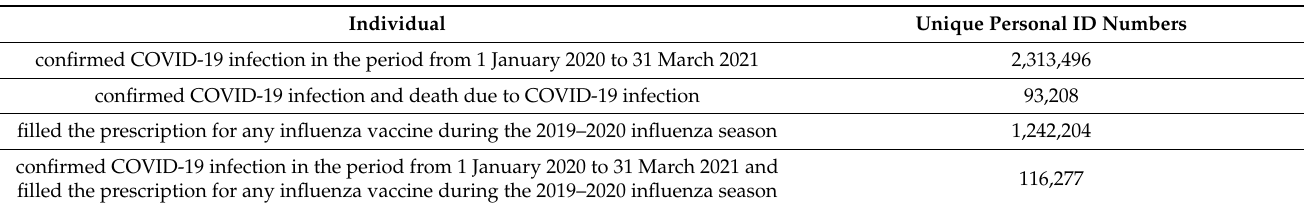
Table 1. Data extracted from CeZ.